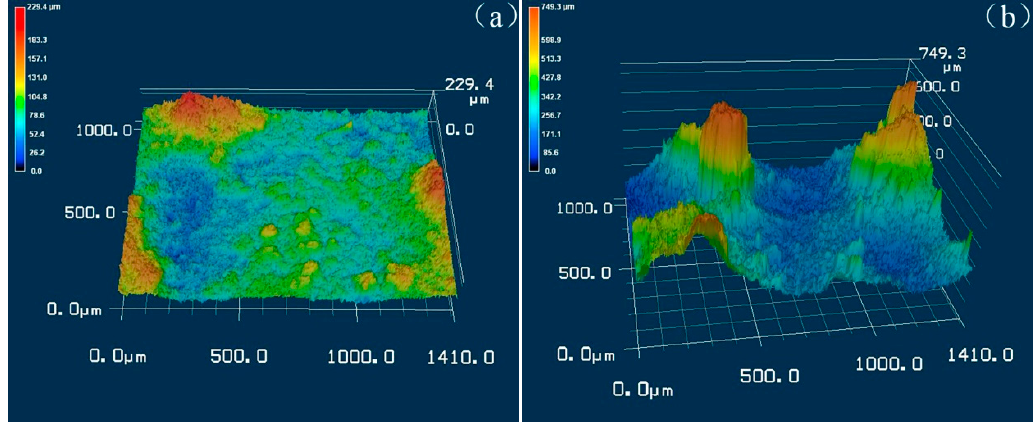
Figure 4. The 3D laser scan image of ( a ) LA143 alloys and ( b ) YAl 2p /LA143 composites’ surface after 72 h immersion in 3.5 wt.% NaCl solution.